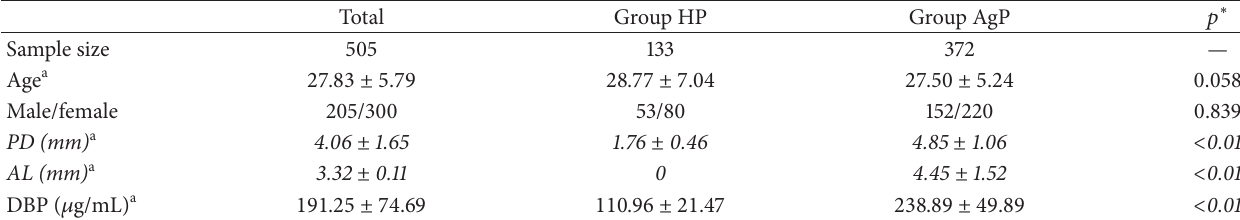
Table 1: Basic characteristics of the study